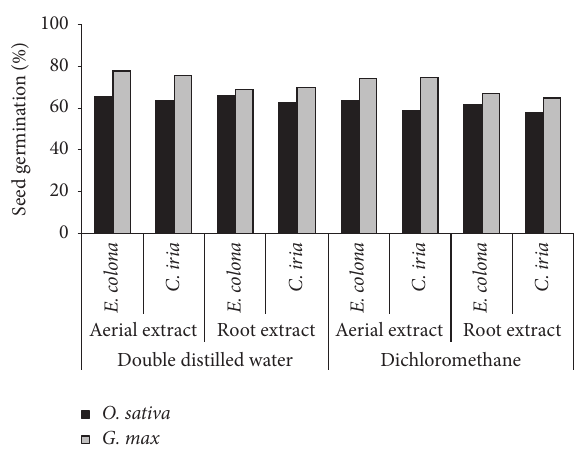
Figure4:Effectsofextracts E.colona and C.iria